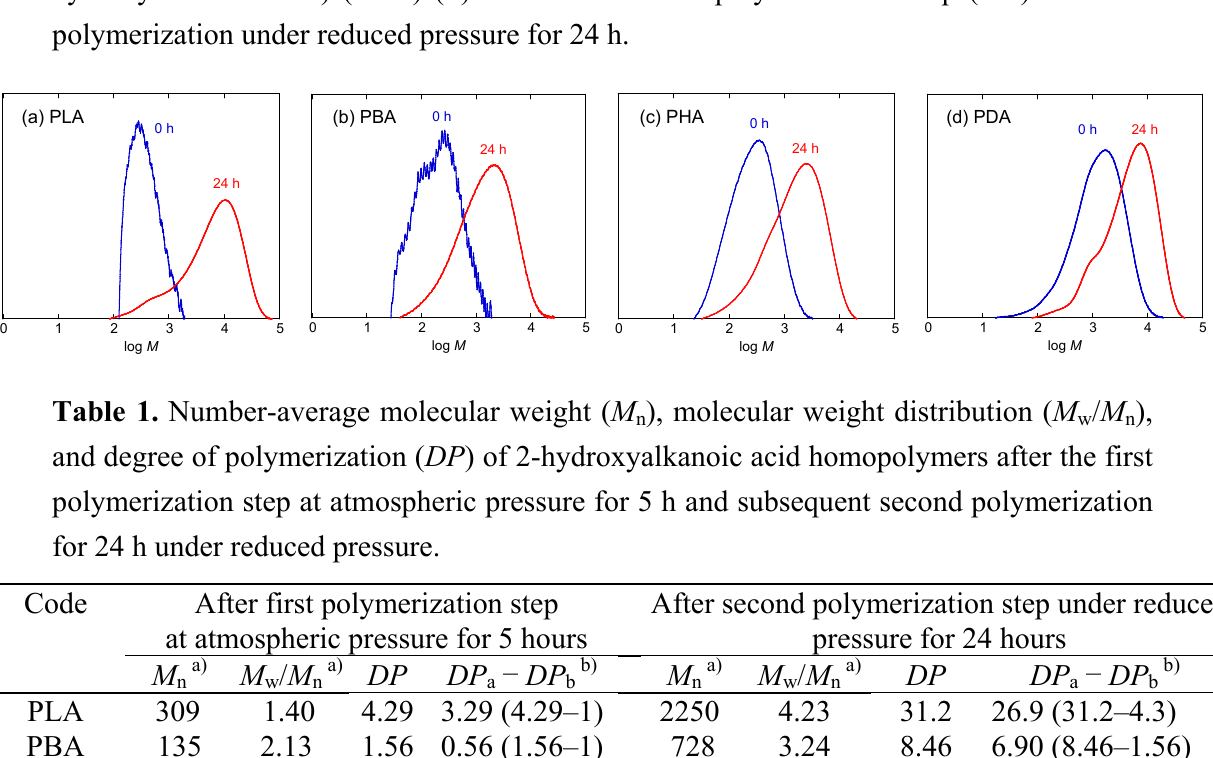
Figure 2. Molecular weight distribution curves of PLA ( a ); poly( DL -2-hydroxybutanoic